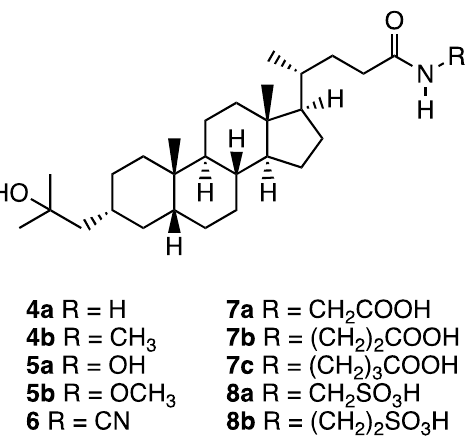
Figure 2. Structures of lithocholic acid amide derivatives 4 – 8.